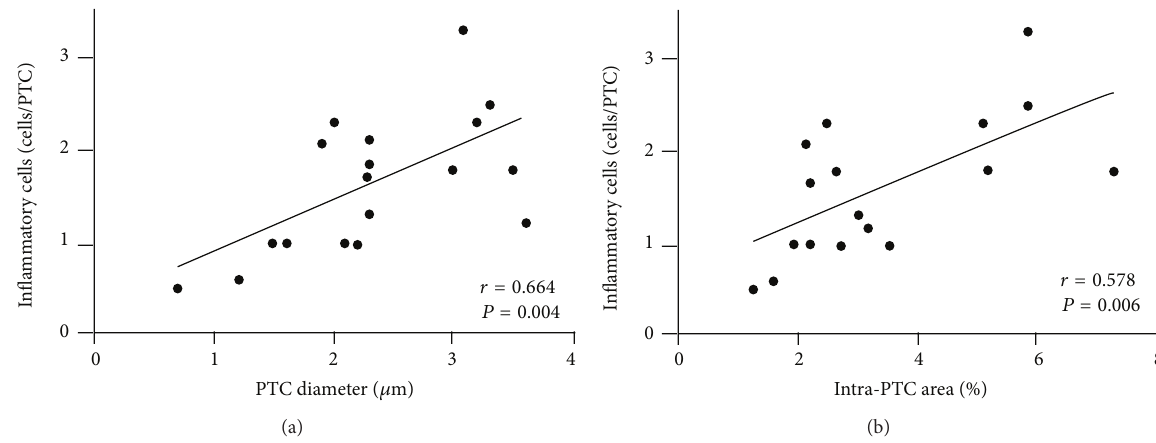
Figure 2: The relationship between microcirculation inflammation and peritubular capillary (PTC) dilation. In the antibody-mediated rejection group, PTC diameter (a) and intra-PTC area (b) were strongly correlated with the number of intra-PTC cells.